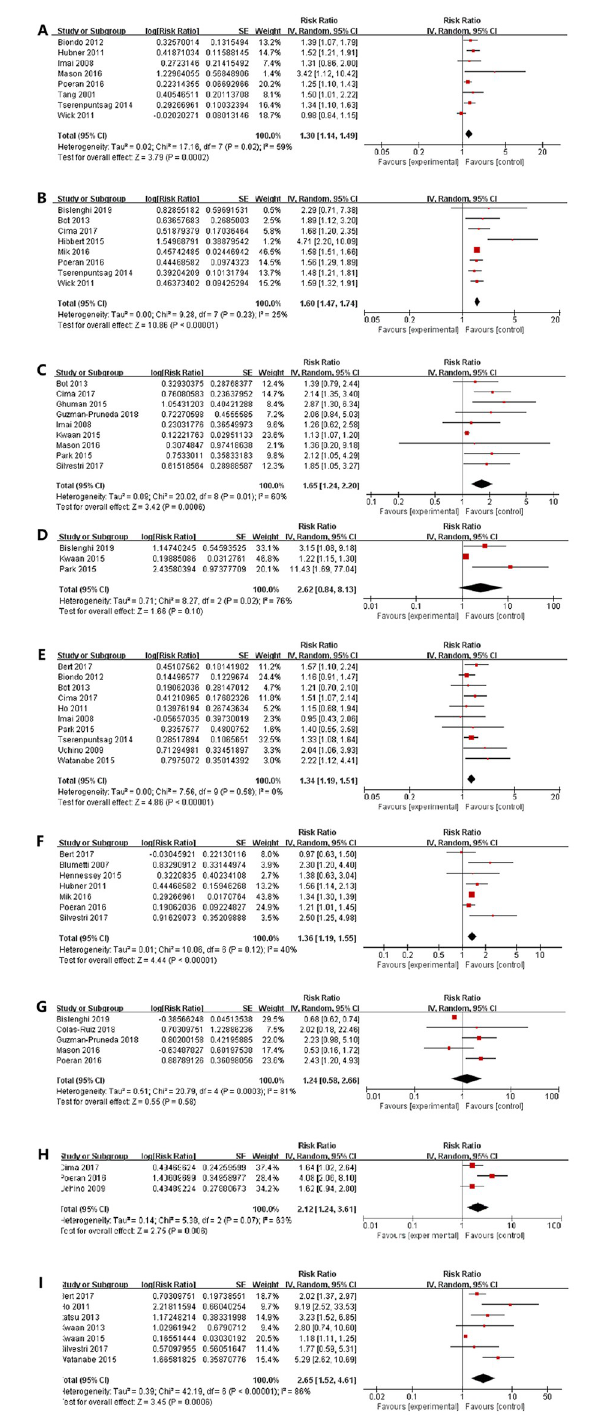
Fig 2. The forest plots showed that the correlations between the risk of SSIs with (A) male sex, (B) obesity, (C) diabetes mellitus, (D) respiratory disease, (E) ASA classification, (F) emergent status, (G) neoplasm, (H) inflammatory bowel disease, (I) wound classification >